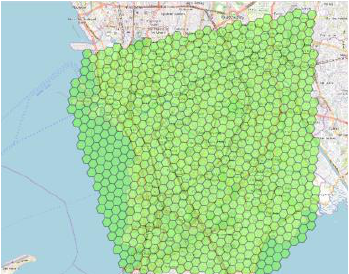
Figure 4. Metro Manila hexagons from Uber Movement